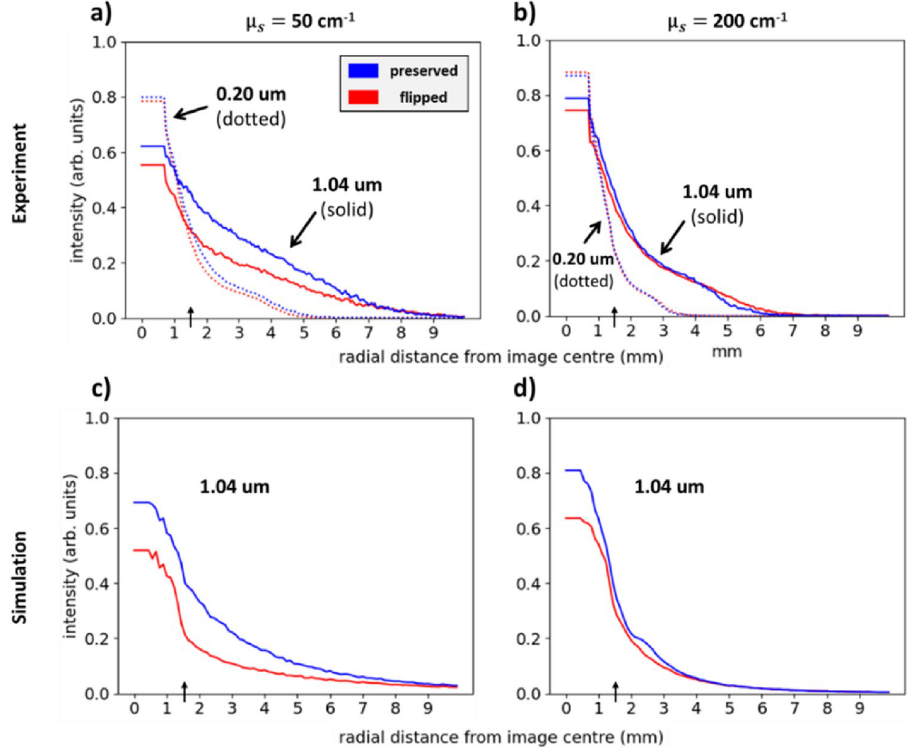
Figure 5. Helicity-flipped and helicity-preserved radial profiles of images corresponding to suspensions with scattering coefficients of 50 cm −1 and 200 cm −1 and sphere diameters of 0.20 μm (dotted lines) and 1.04 μm (solid lines). The vertical arrows along the x-axes mark the outer edge of the IR. The simulation radial profiles in ( c ) and ( d ) exclude the 0.20 μm data (see text for details). Scatterer size and turbidity information can be gleaned by analyzing these profiles, for example, enhanced preserving-to-flipping ratio by larger spheres and increased confinement (narrowing of the profiles) with